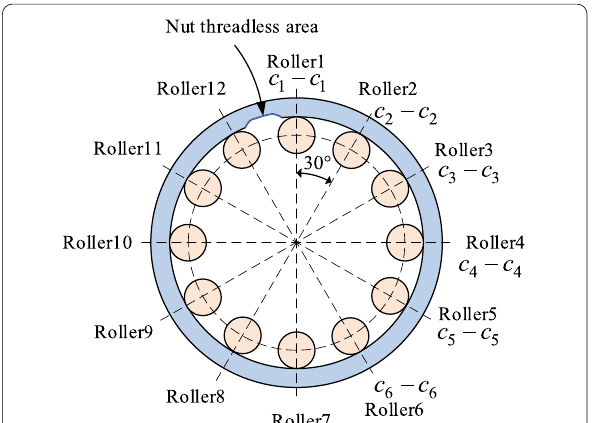
② The reference plane over the center axis of the roller is overlapped with the corresponding ref- − c 1 erence plane c 1 of the nut. Referring to Fig- ure 16, the roller assembly diagram shown in Fig- ure 19 can be obtained by viewing from the right to the left, and establish six reference planes over − c the axis of the nut, that is c i i , i = 1, …, N/ 2. ③ The reference plane a − a of roller 1 and the − b 1 carrier reference plane b 1 are overlapped.